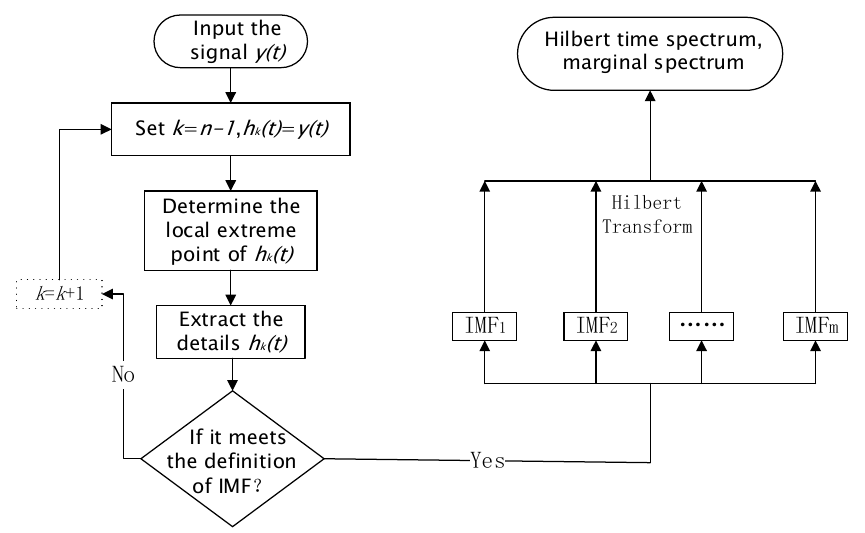
Figure 1. Flowchart of the HHT algorithm.